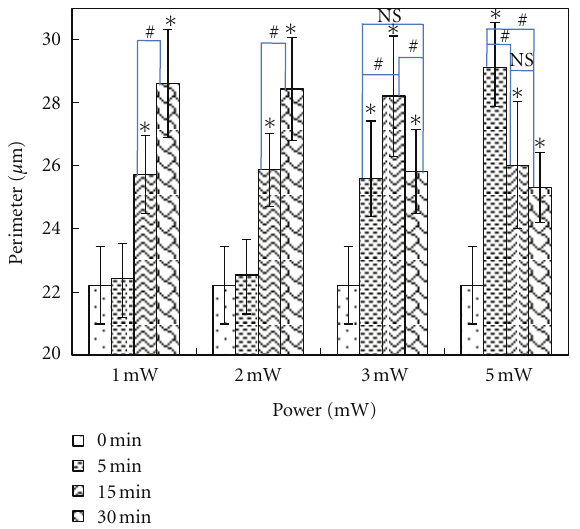
Figure 2: E ff ects of laser irradiation on the perimeter of dehydrated erythrocytes. Data are means ± SD. N = 100. ∗ P < 0 . 05 versus the no irradiation group as control, # indicate significant di ff erences between the two groups, # P < 0 . 05, and NS indicate no significant di ff erences between the two